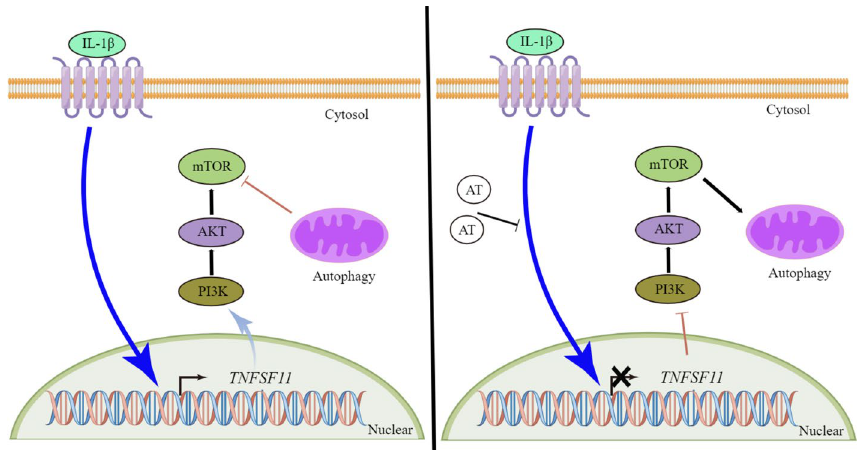
Fig. 7 Schematic working model. AT suppressed the expression of TNFSF11 and inhibited the PI3K–AKT– mTOR pathway in IL-1β induced OA. In the absence of AT, TNFSF11 activated the PI3K–AKT–mTOR pathway to inhibit autophagy in IL-1β induced OA. In the presence of AT, downregulated TNFSF11 suppressed the PI3K– AKT–mTOR pathway to promote autophagy in IL-1β-induced